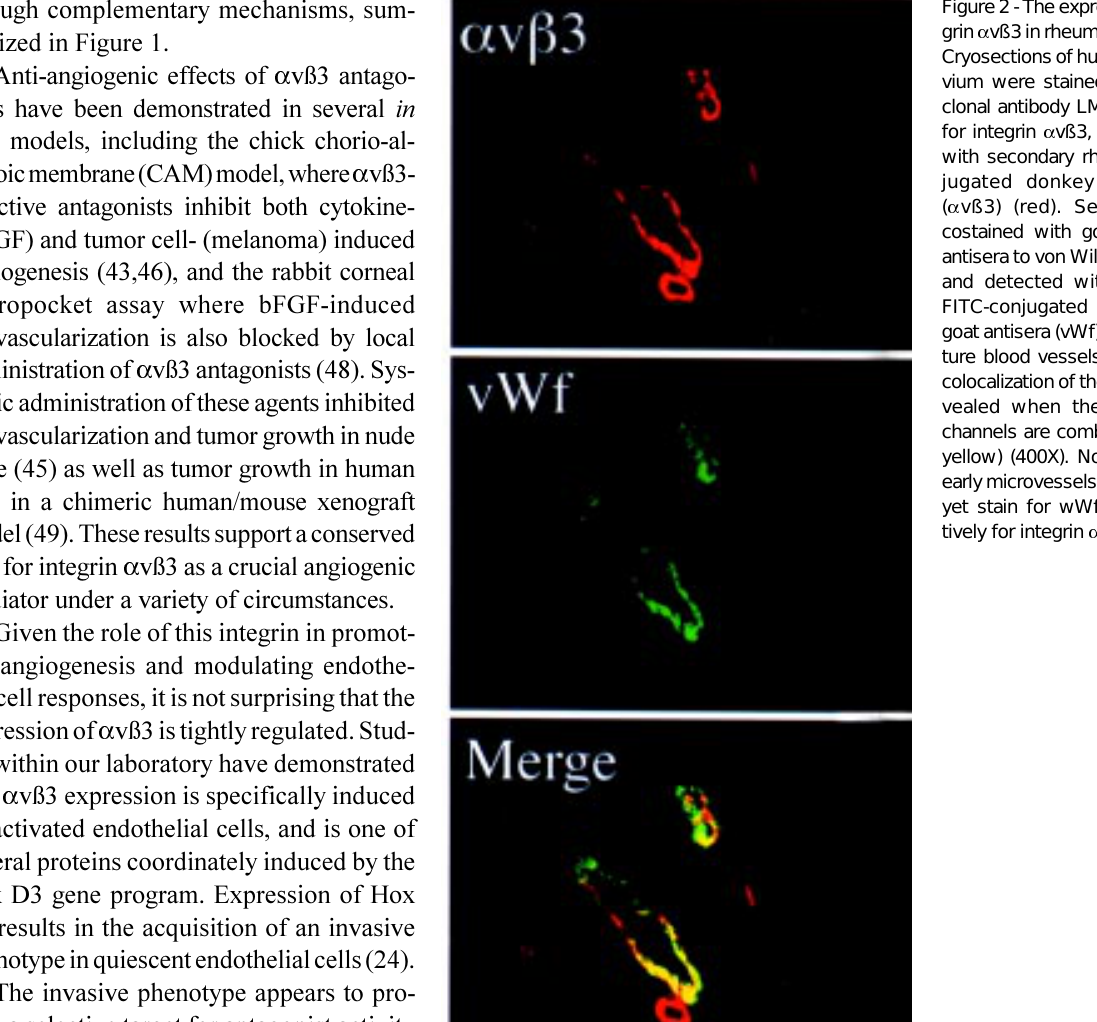
Figure 2 - The expression of inte- grin a vß3 in rheumatoid arthritis. Cryosections of human RA syno- vium were stained with mono- clonal antibody LM609, specific for integrin a vß3, and detected with secondary rhodamine-con- jugated donkey anti-mouse ( a vß3) (red). Sections were costained with goat polyclonal antisera to von Willebrand factor and detected with secondary FITC-conjugated donkey anti- goat antisera (vWf) to reveal ma- ture blood vessels (green). The colocalization of the signals is re- vealed when the fluorescent channels are combined (Merge, yellow) (400X). Note that many early microvessels, which do not yet stain for wWf, stain selec- tively for integrin a